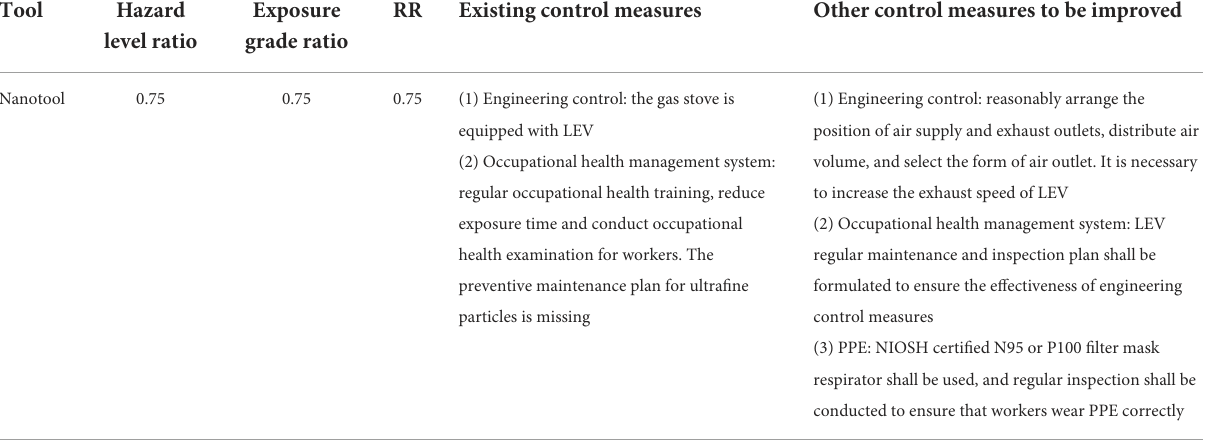
TABLE 6 Risk assessment and control